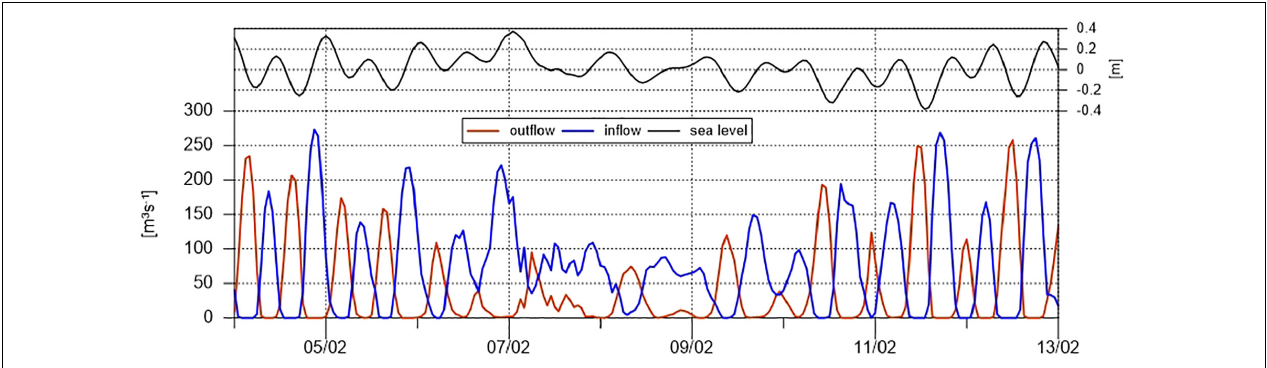
FIGURE 5 | (Bottom panel) Time series of the net volume inflow/outflow in m 3 s - 1 calculated in the western inlet channel of the inlet section of Figure 4 and (top panel) sea level in m calculated at the sampling point B2, for 1 week (5–13) of February 2018.